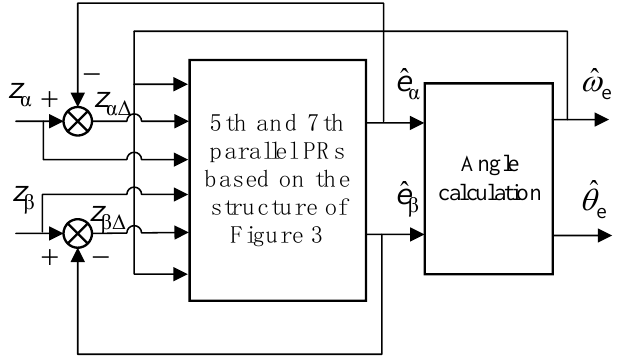
Figure 5. Closed-loop control block diagram of MPF. The z α , z β containing the harmonics of the back EMF were filtered by the closed-loop MPF, and the filtered back EMF ˆ e α ˆ e β was obtained. At the same time, the back EMF z α , z β containing harmonics and the back EMF error z α ∆ , z β ∆ were used as the input